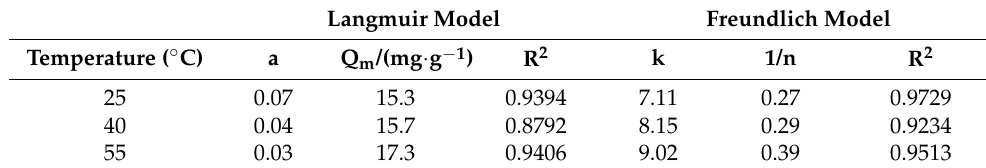
Figure 11. Langmuir ( a ) and Freundlich adsorption isotherm ( b ). Table 3. Fitting results of two isothermal lines.